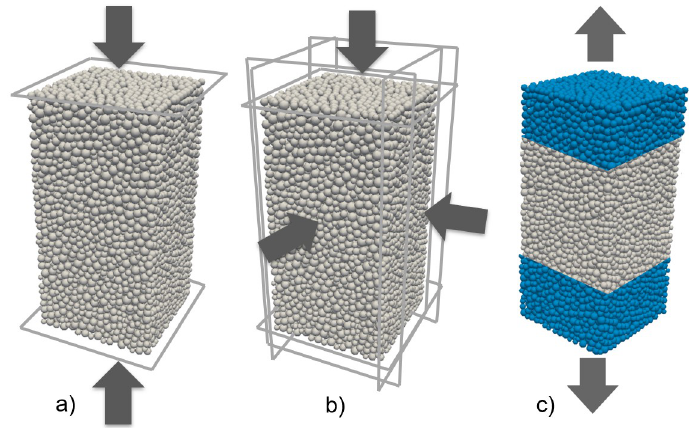
Fig 2. Numerical model samples. (a) Uniaxial compressive (b) Triaxial compressive (c) Direct tensile test configurations (The arrows show the loading directions during the simulations).